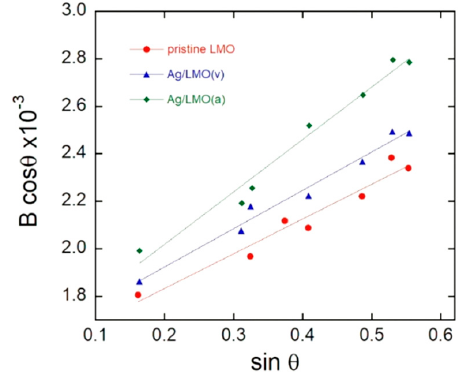
Figure 4. Determination of the microstrain ε from the full-width at half-maximum, B hkl , of XRD peaks according to Equation (1).